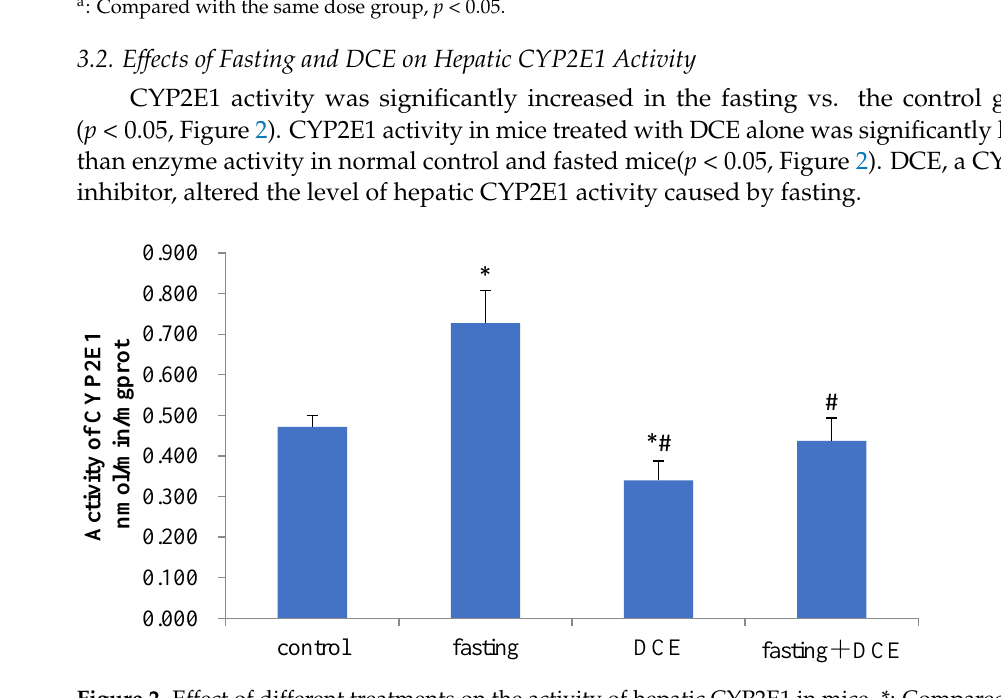
Figure 2. Effect of different treatments on the activity of hepatic CYP2E1 in mice. *: Compared with the control group, p < 0.05.#: Compared with fasting group, p < 0.05.